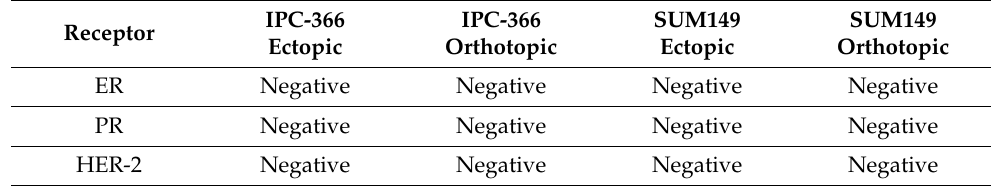
Table 2. Estrogen receptor (ER), Progesterone receptor (PR), and human epidermal growth factor receptor 2 (HER-2) expression on ectopic and orthotopic xenografts from IPC-366 and SUM149 cell